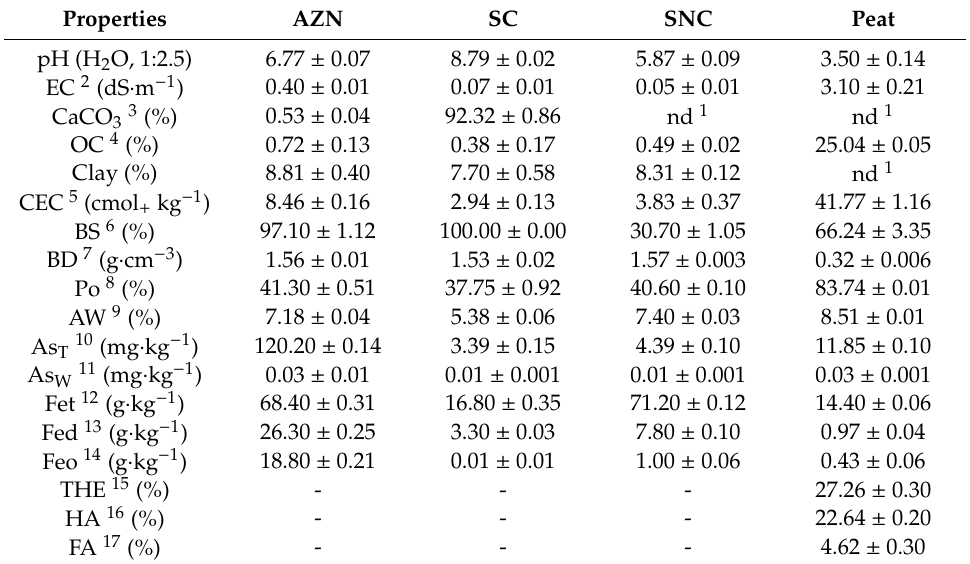
Table 1. Main properties of the selected soil samples and peat (mean ± standard